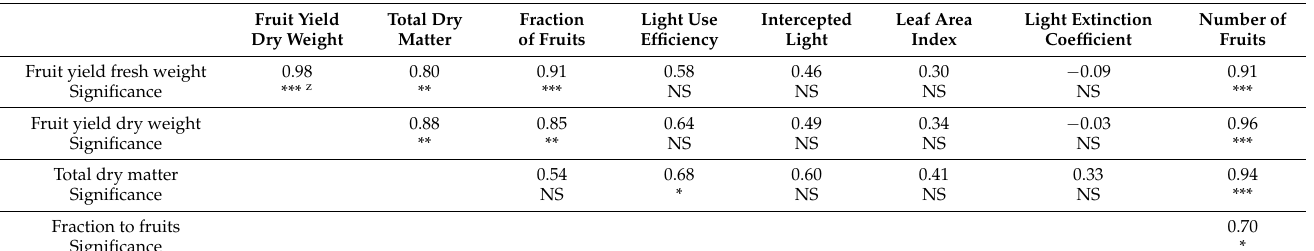
Table 2. Correlation coefficient (r) between yield components and growth characteristics of cucumber cultivars at 96 days after